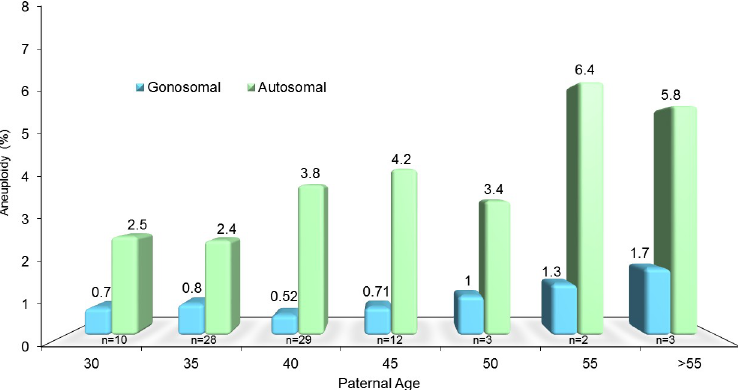
Fig 1. Sperm aneuploidy assessment by FISH depicting sperm chromosomal defects. A comparison between autosomal aneuploidy and male age, assesed by Pearson’s Correlation Coefficient, had an R 2 value of 0.6 ( P < 0.00001). Data has been allocated into different age bins, as shown, for clinical relevance and visual representation.